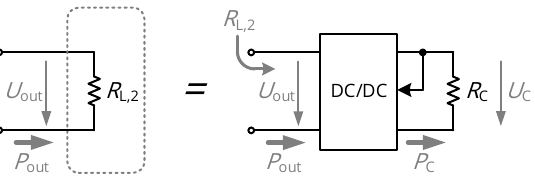
Figure 2. Realization of the DC load resistance R L,2 as a combination of an output-controlled DC/DC voltage converter and the load circuits of resistance R C . The DC/DC converter thereby acts as an impedance